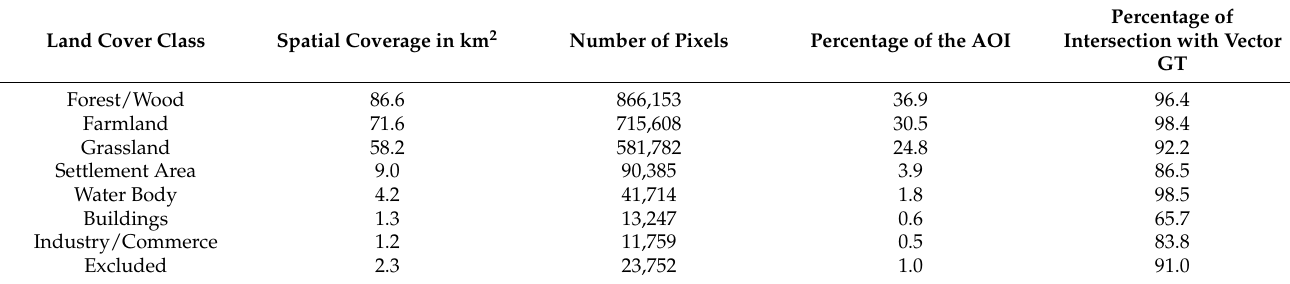
Table 1. Land cover classes with their spatial coverages, the number of covered pixels (each 10m × 10m), percentages of the area of interest (AOI), and relative intersection of the rastered GT with the vector GT. Seven classes with the smallest number of pixels are summed up as Excluded